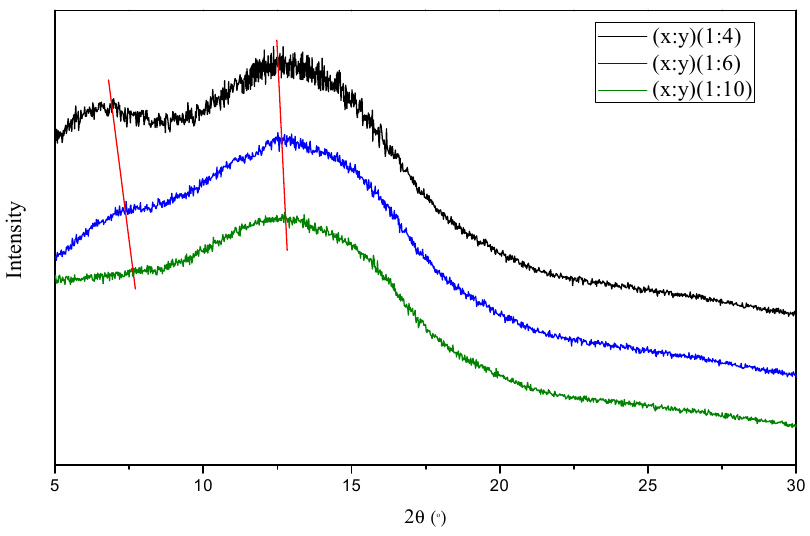
Figure 4 . Wide-angle XRD diagrams of the [(PIM-PI)x-(6FDA-durene-PI)y] copolymers with different PIM-PI compositions .